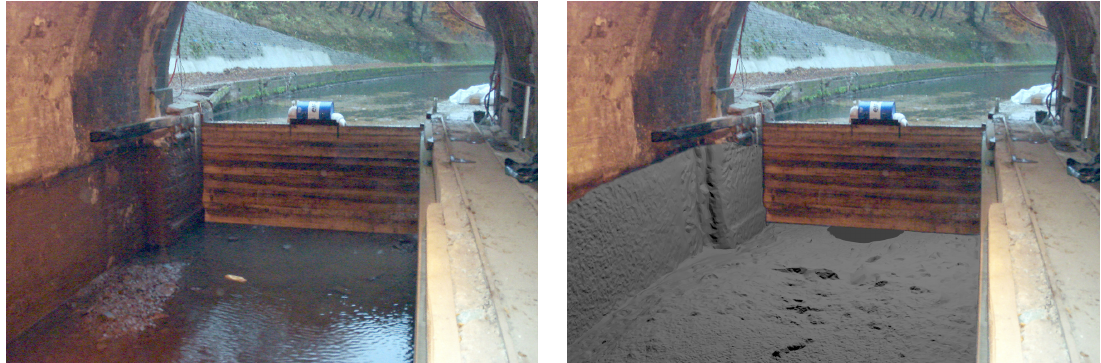
Figure 11. ( Left ) Photograph on the northern tunnel entry, during its emptying for maintenance in 2009 (source: Voies Navigables de France (VNF) archives); ( Right ) Visualization of the MSS denoised model (in grey) superimposed on the image. The orientation is done manually, thanks to the masonry block and the cofferdam grooves, which are visible in the